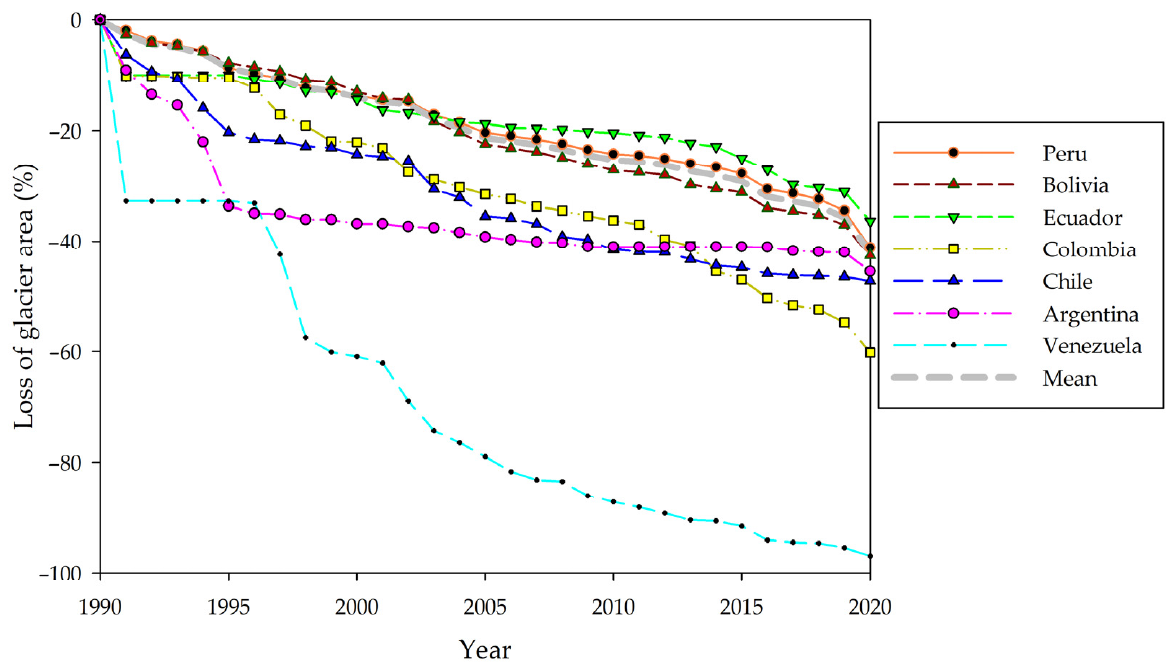
Figure 14. Evolution of the TAGs’ annual coverage loss by country in the period from 1990 to 2020.